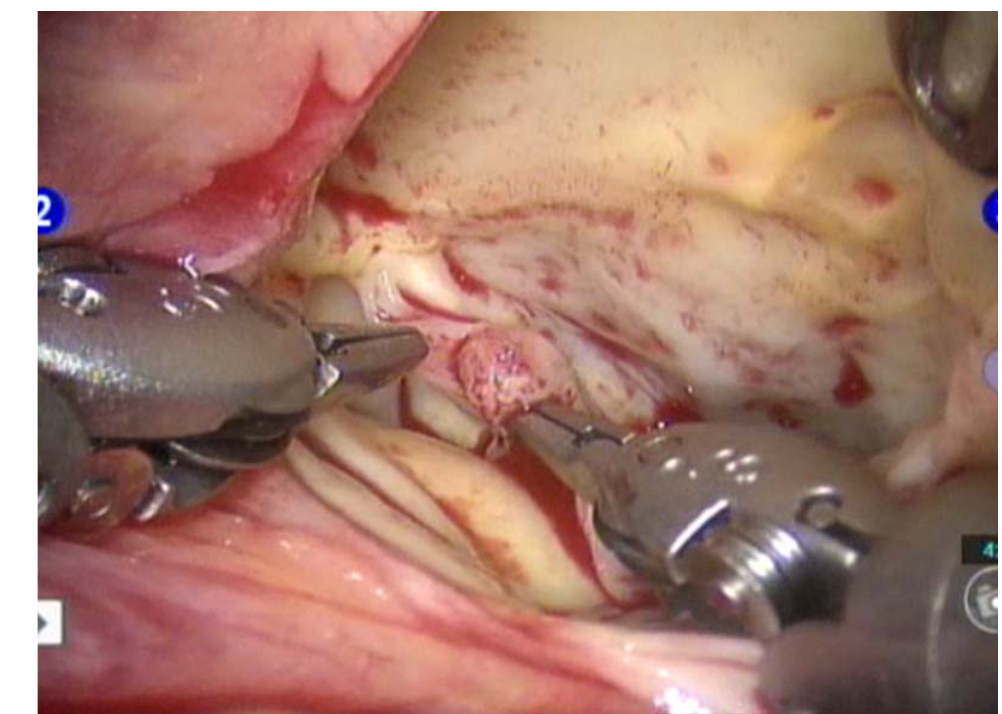
Figure 3. Intraoperative view/video of left coronary cusp